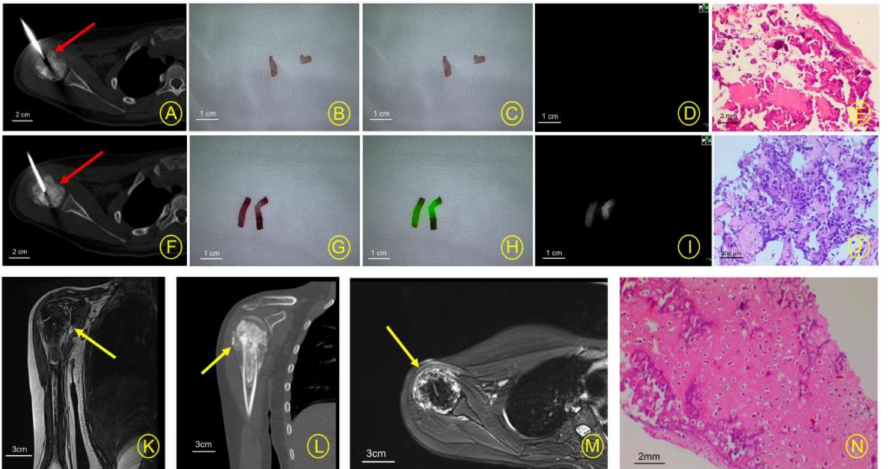
Figure 5. ( A ) Under the guidance of CT, the biopsy needle was implanted into the lesion (red arrow). ( B – D ) The naked-eye view of the biopsy lesions and real-time fluorescence imaging of the lesion specimens (no fluorescence imaging). ( E ) Pathological results of the first biopsy (necrotic tissue). ( F ) The direction and position of the needle track were adjusted immediately, and the focus was obtained again. After the end of the biopsy, the specimen was developed with real-time fluorescence. In the picture, the biopsy needle was implanted into the lesion (red arrow). ( G – I ) The naked- eye view of the biopsy lesions, the green fluorescence, and original fluorescence of the real-time fluorescence development of the supplementary biopsy lesions. ( J ) The pathological results of the supplementary biopsy (osteosarcoma). ( K – M ) Imaging data before biopsy (yellow arrow). ( N ) The pathological results (osteosarcoma) after surgical resection of the humeral tumor were consistent with the pathological results of the